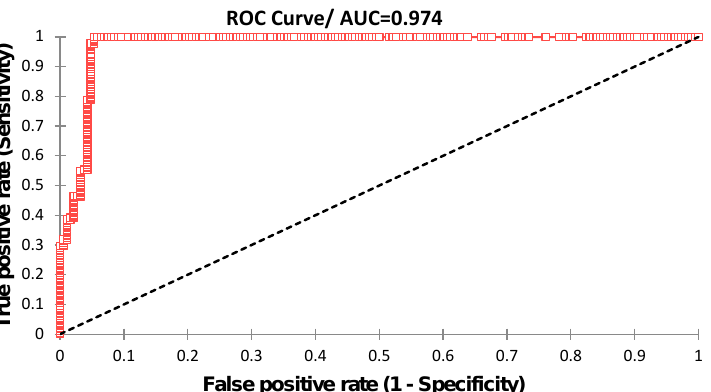
Figure 1. ROC curve of the EDIII IgG ELISA showing the evolution of sensitivity and false positive rate at each OD value. Table 3 summarizes the AUC values obtained from the ROC curve: Table 3. AUC parameters.